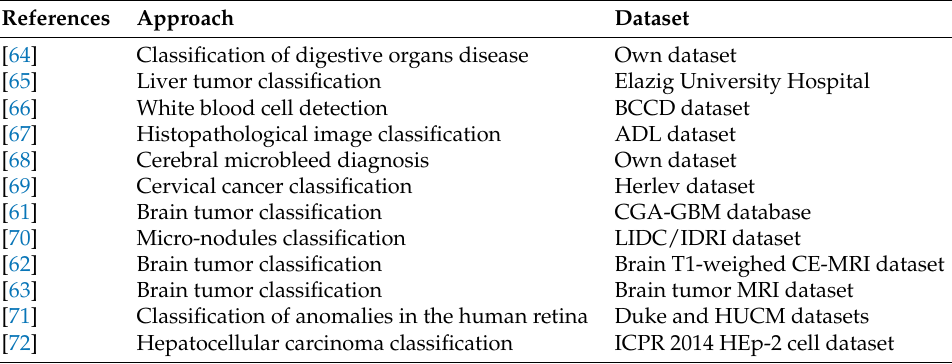
Table 4. Applications in medicine and their datasets reported in the primary studies.